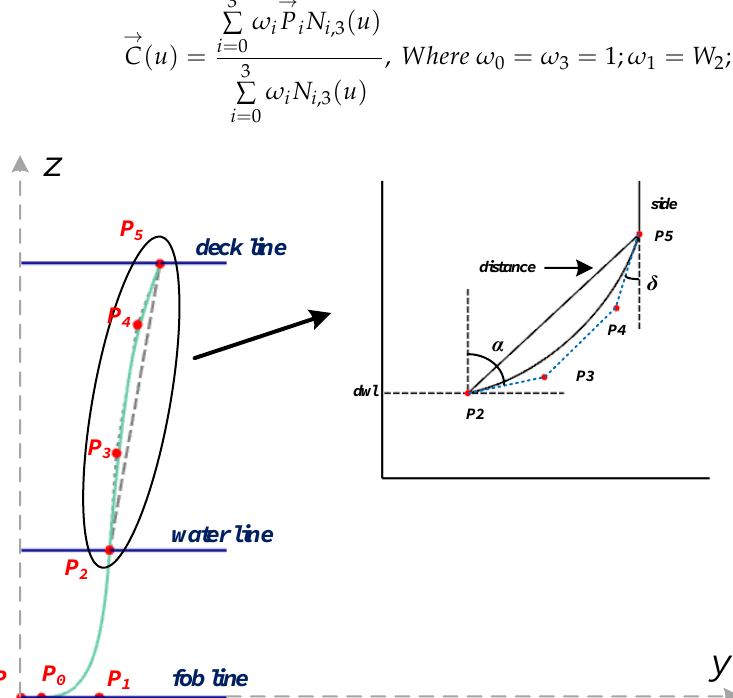
Figure 13. Schematic diagram of the cross-section curve.